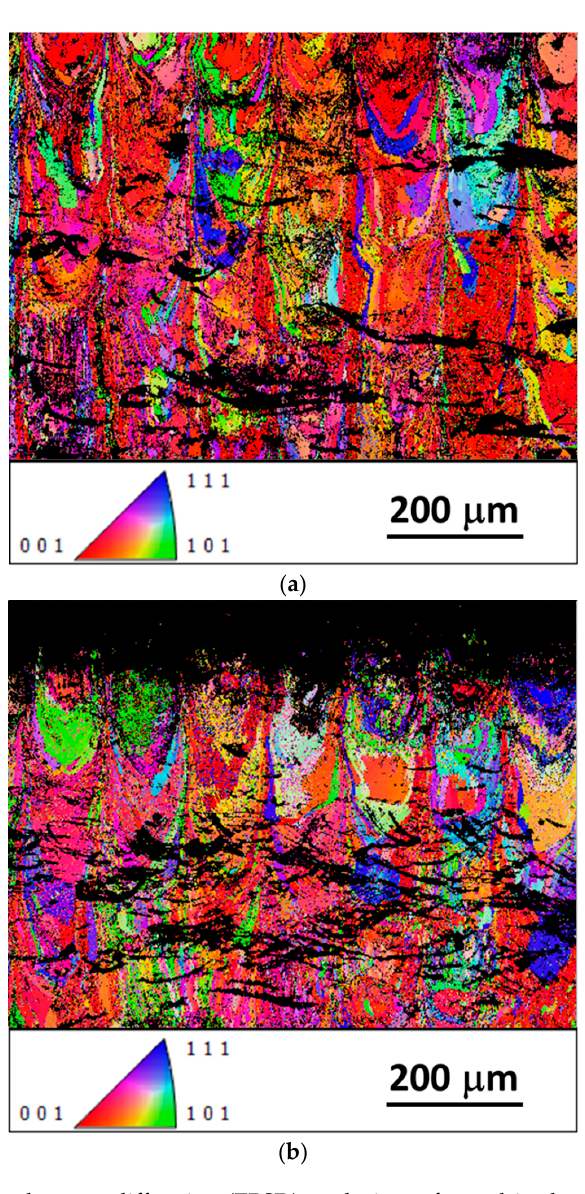
Figure 6. Electron backscatter diffraction (EBSD) analysis performed in the x–z view of the two conditions: as-built ( a ) and UNSMed samples ( b ), according to orientation map micrograph related to the building direction.